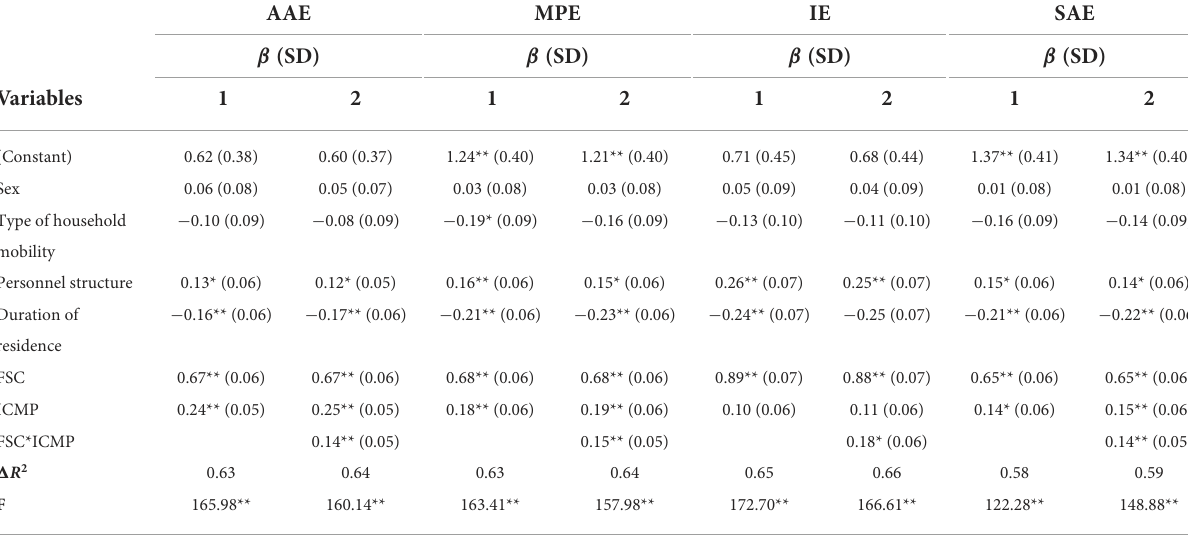
TABLE 6 Moderating effect of ICMP on the relationship between FSC and educational expectations.